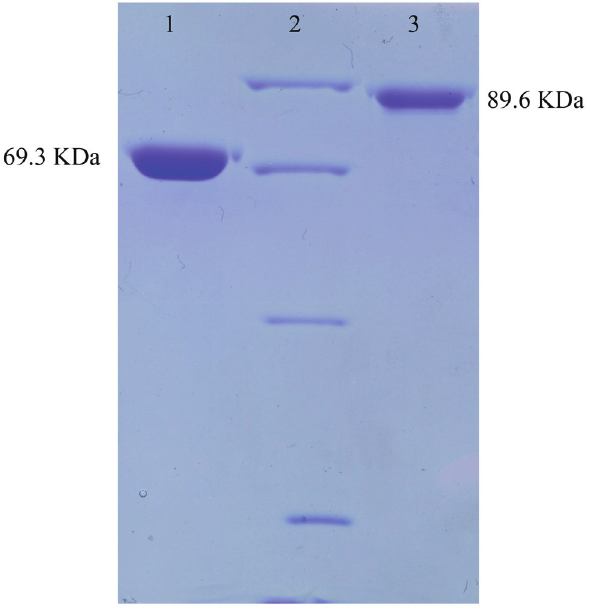
Figure 4. The electrophoresis of ChiA and ChiC. Purified ChiA and ChiC were loaded on 10% SDS-PAGE followed by Coomassie staining. Lane 1, Purified ChiA; lane 2, Middle ranged protein marker (Shenggong, Shanghai, China; 97.4 KDa, 66.2 KDa, 42.7 KDa, 31.0 KDa); lane 3, purified